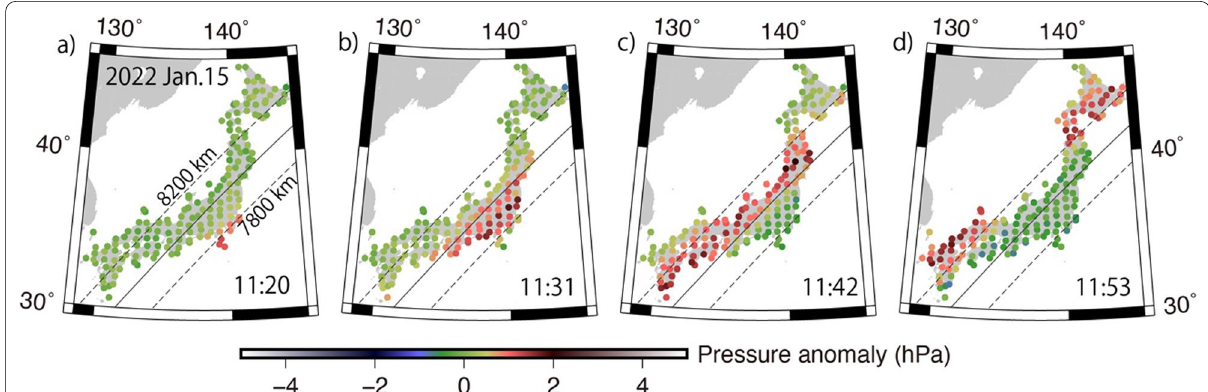
Fig. 2 The first passage of the LW on Jan. 15 shown with 4 snapshots from 11:20 to 11:53 UT. Atmospheric pressure anomaly, obtained as the deviation from best-fit polynomials, show the wavefront parallel to the distance contours and northwestward propagation as fast as ~ 0.3 km/s